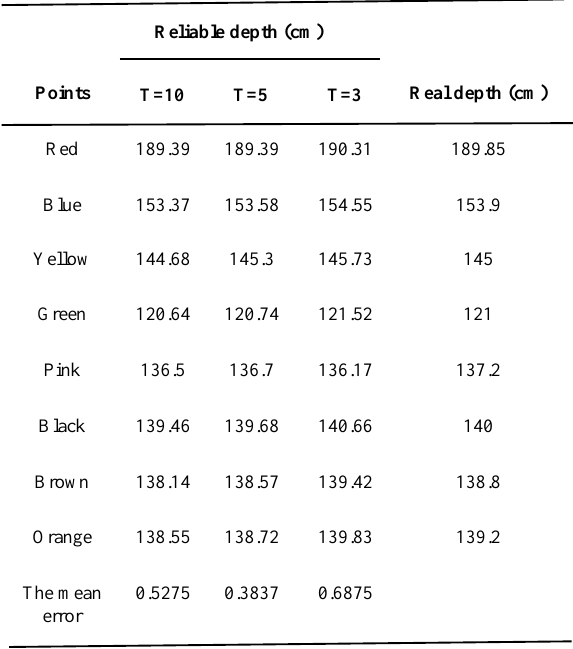
Table 1. Reliable depth value using the different thresholds for